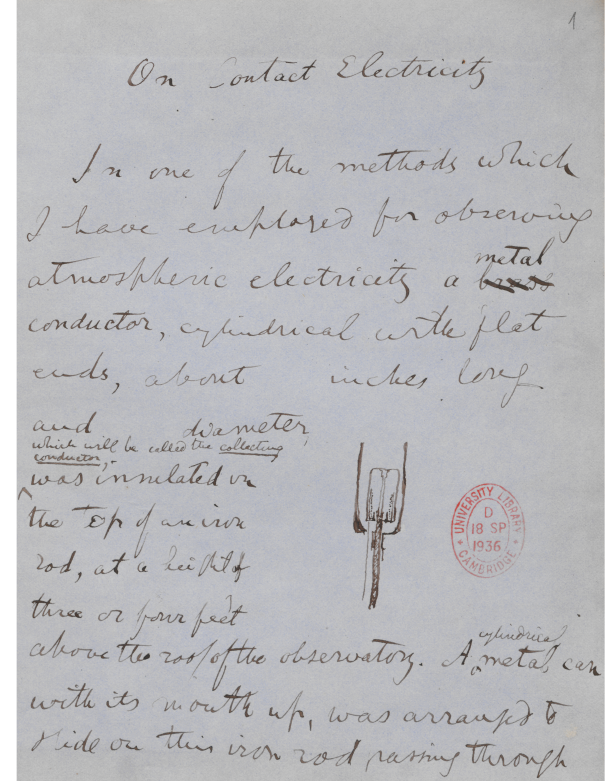
Figure A1. Page from Notebook 35 describing the winched can sensor, with a sketch of the